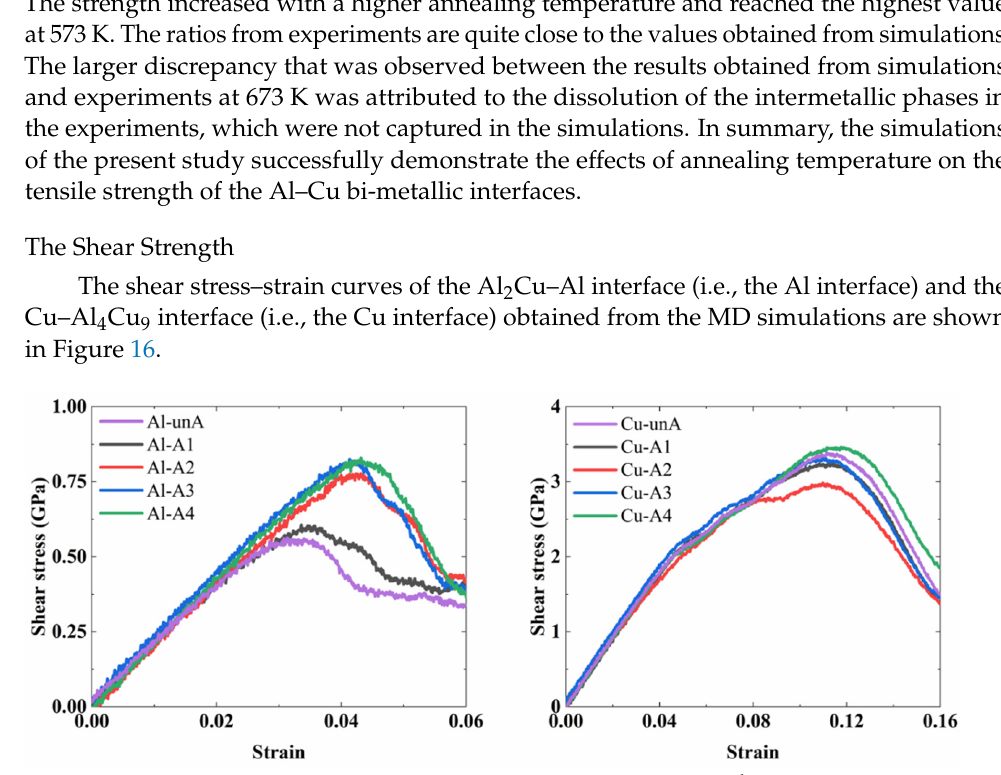
Figure 16. The shear stress–strain curves of the interfacial structures before annealing and at differ